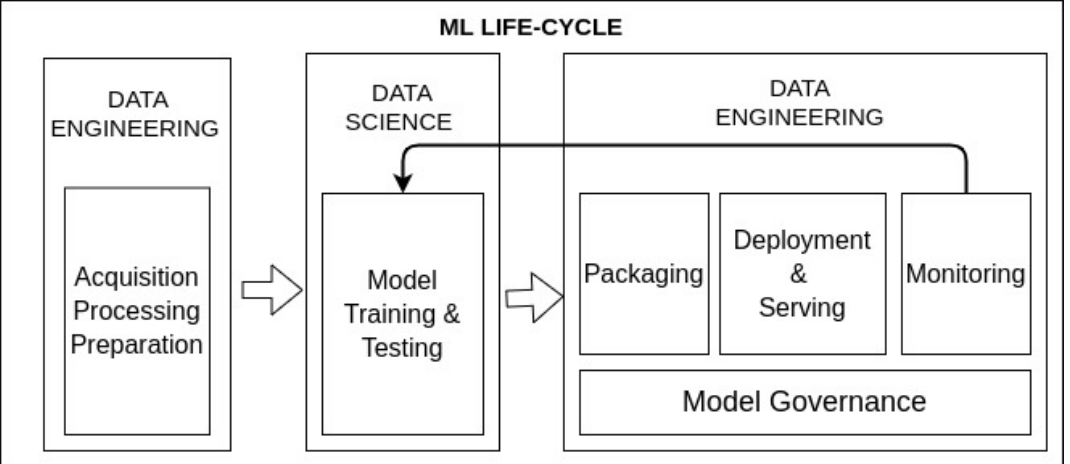
Figure 1. Main phases of the ML life cycle targeted at operationalising ML models in produc- tion